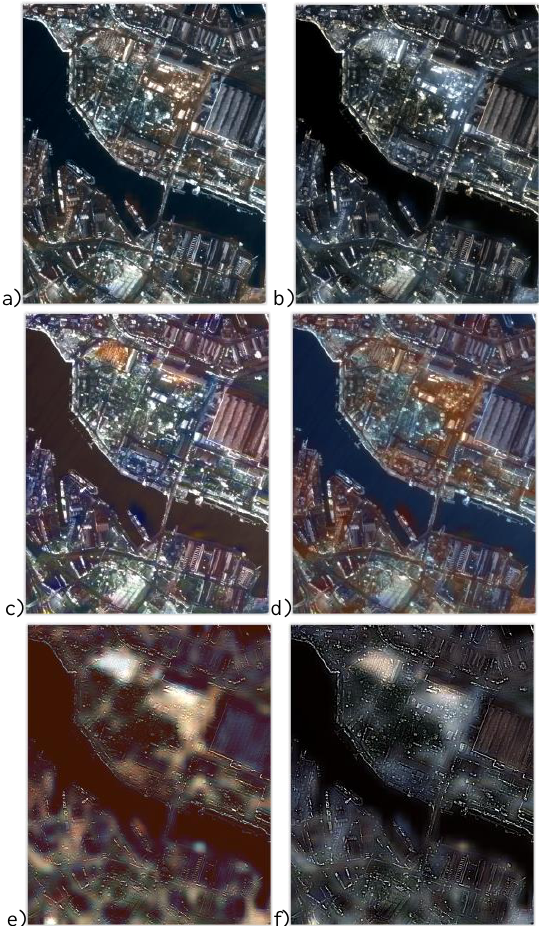
Figure 4. Results of pan-sharpening of the urban area image based on: Brovey’s (a), Multiplicative (b), PCA (c), IHS (d), Ehler’s (e), HPF (f)